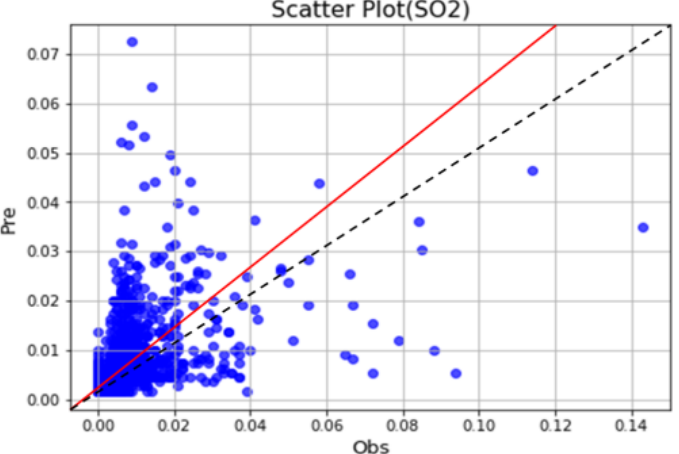
Figure 10. Comparison results of predicted sulfurous acid gas with observations. The regression line of observed and predicted data is indicated in red.